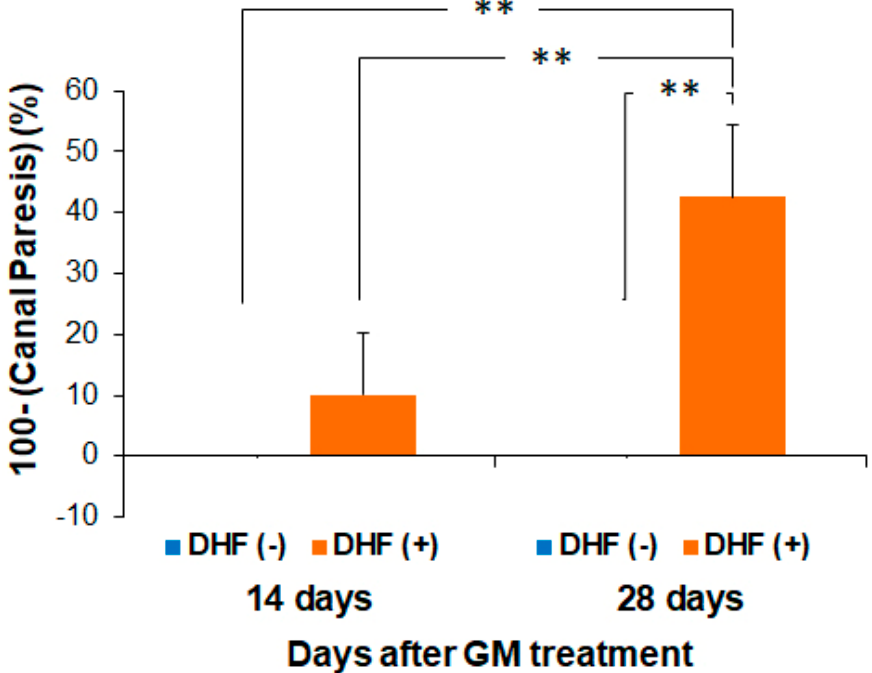
Figure 6. Evaluation of vestibular function. The DHF ( − ) group showed no nystagmus 14 or 28 days after GM–induced injury. In addition, the canal paresis was significantly improved in the DHF (+) group than in the DHF ( − ) group. N = 5 each for control, DHF (+) and DHF ( − ) at 14 and 28 days. DHF, 7, 8–Dihydroxyflavone; GM, gentamicin; ** p < 0.01, tested by the Mann-Whitney U test by comparing with DHF (+) at 28